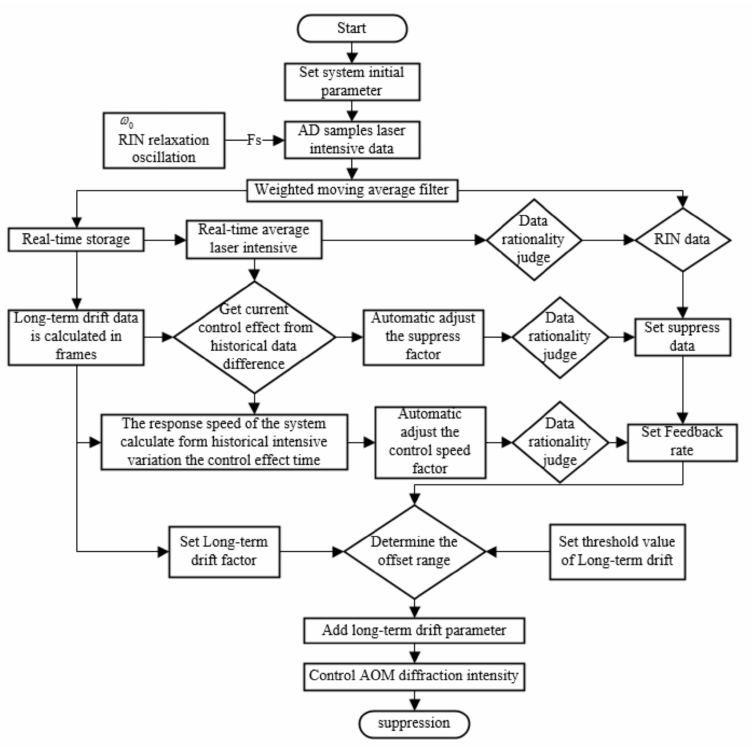
Figure 5. Suppression process of the external laser intensity control method.